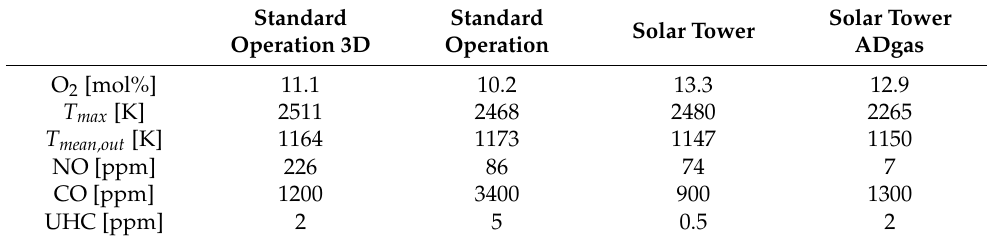
Table 4. Combustor outputs from CFD based simulations